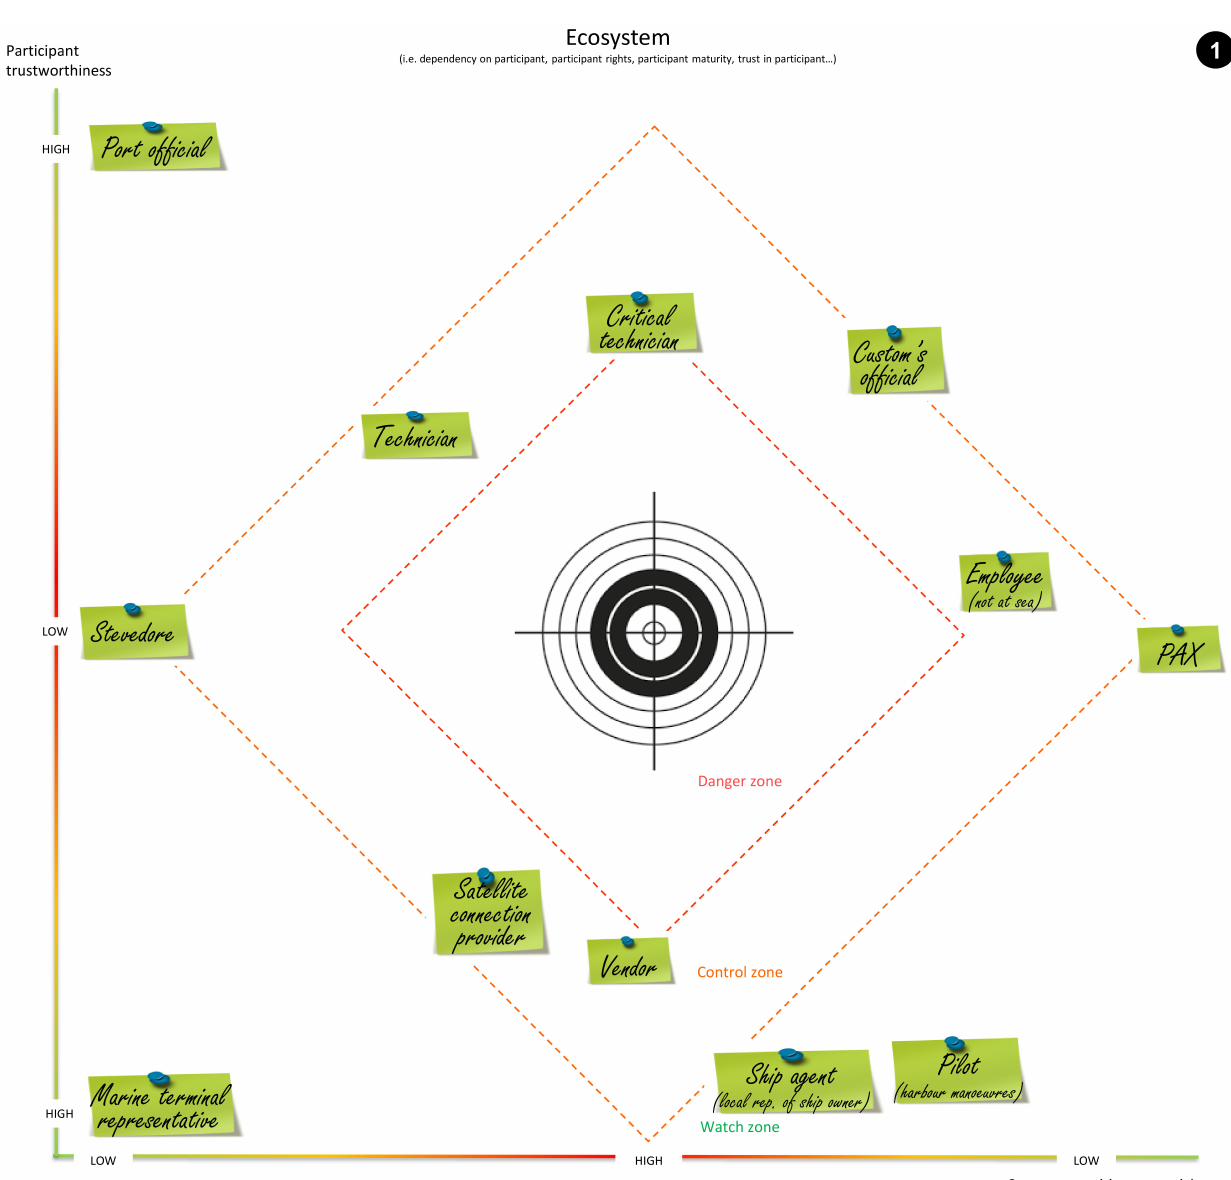
Figure 10. Naval use case—identification and assessment of the ecosystem participants. The chart layout requires some oral explanations at the beginning of the workshop, but the return on the experience shows that it is easily accepted. This layout was recommended to us by the French cybersecurity agency (ANSSI) during a review of the very early drafts of the Ob é risk datasheets. The layout has proved to be very efficient since then. The radar-like diagram also displays two lozenges, delimitating three zones: the watch zone (in green), the control zone (in orange) and the danger zone (in red).